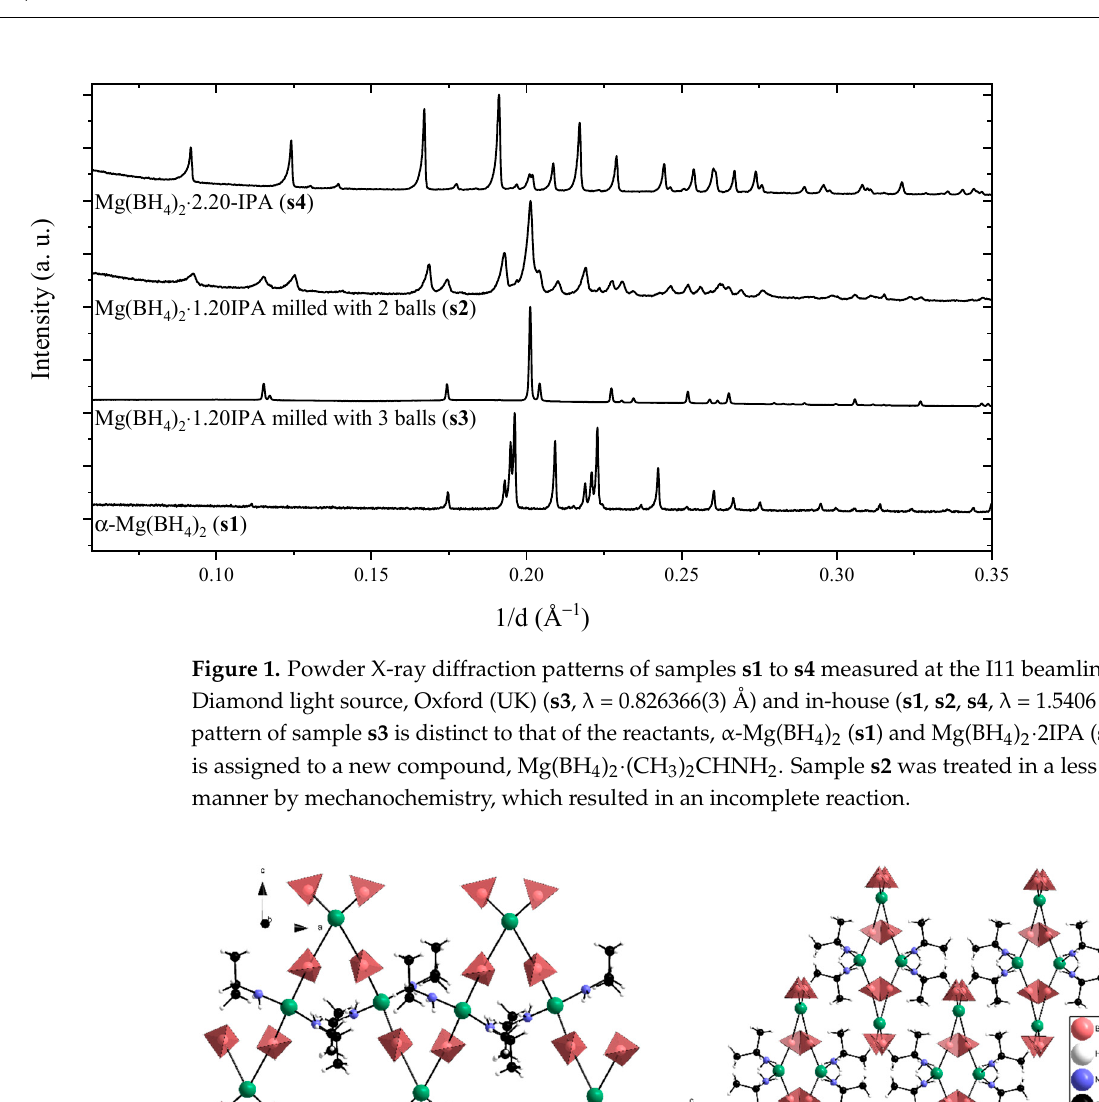
Figure 3. Rietveld refinement of the structural model of Mg(BH 4 ) 2 ∙ (CH 3 ) 2 CHNH 2 in the space group I2 1 2 1 2 1 , using the powder X-ray diffraction pattern of Mg(BH 4 ) 2 ∙ 1.20IPA ( s3 ). R-factors: R p = 1.26, R wp = 2.47, conventional R-factors: R p = 37.6 and R wp = 23.2 and R Bragg = 20.3. The DFT structural optimization was done with two different exchange–correlation functionals with and without accounting for van-der-Waals (vdW) interactions, beginning from the experimental structure shown in Figure 2. Independently of the used functions, it was found that the experimental structure is metastable and that it becomes increasingly disordered upon further refinement. This indicates a ‘flat energy landscape’ between the experimental structure and various disordered structural models (see Figures S1–S4 and Table S1 in the supporting information). In all DFT optimizations (with and without vdW), the distance between CH 3 groups in neighboring IPA molecules increases to about 3.5–3.9 Å. This indicates that the interactions between the CH 3 groups are weak. Calculations for the butane dimer reveal typical vdW C–C distances of around 4 Å [21].